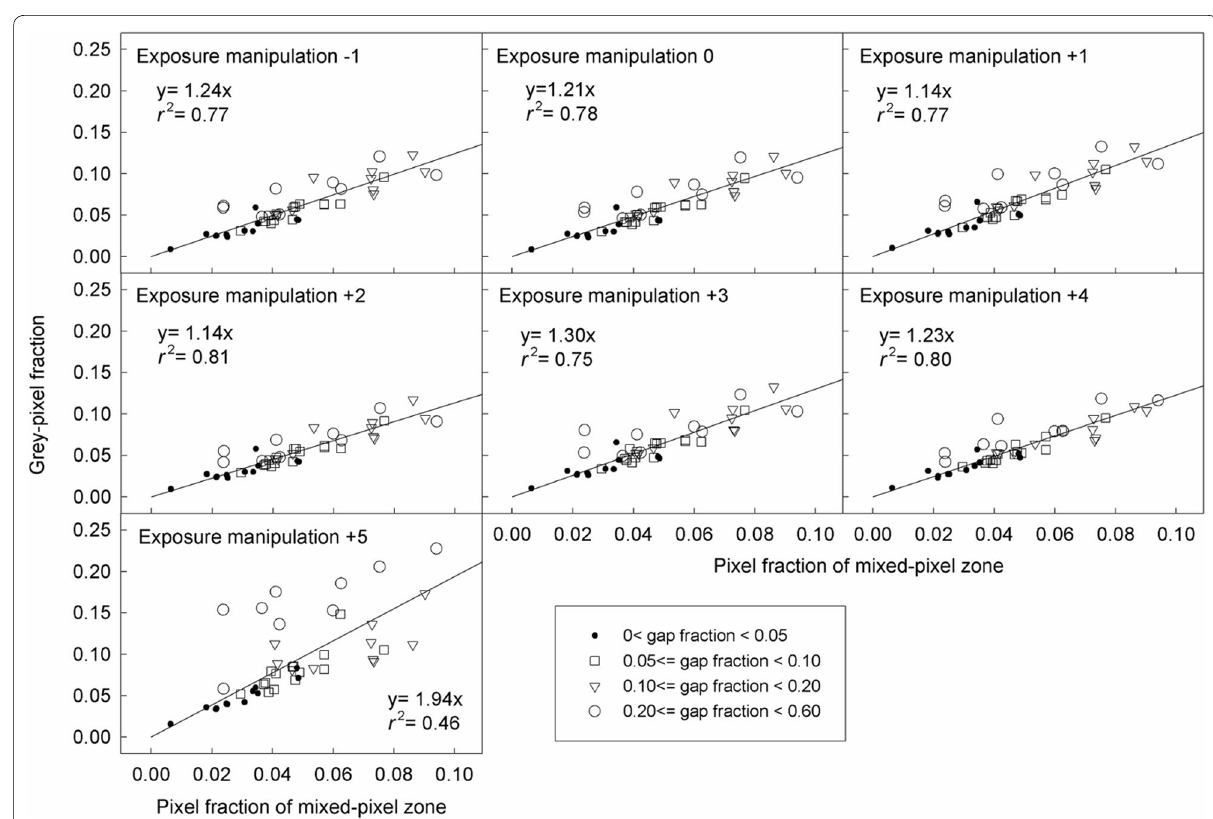
Fig. 5 Relationships between the grey‑pixel fraction and the mixed‑pixel zone length in real CHPs. The pixel fraction of mixed‑pixel zone is an approximation of the SCB length. The unit of the exposure manipulation is stop